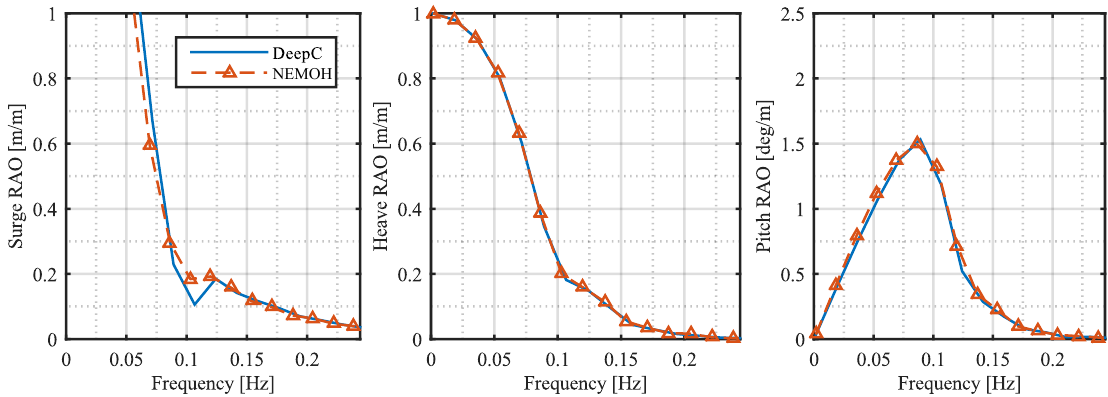
Figure 4. Motion response amplitude operators (RAOs) for the surge, heave and pitch degree of freedoms (DOFs) of the unmoored WEC calculated from the DeepC and NEMOH